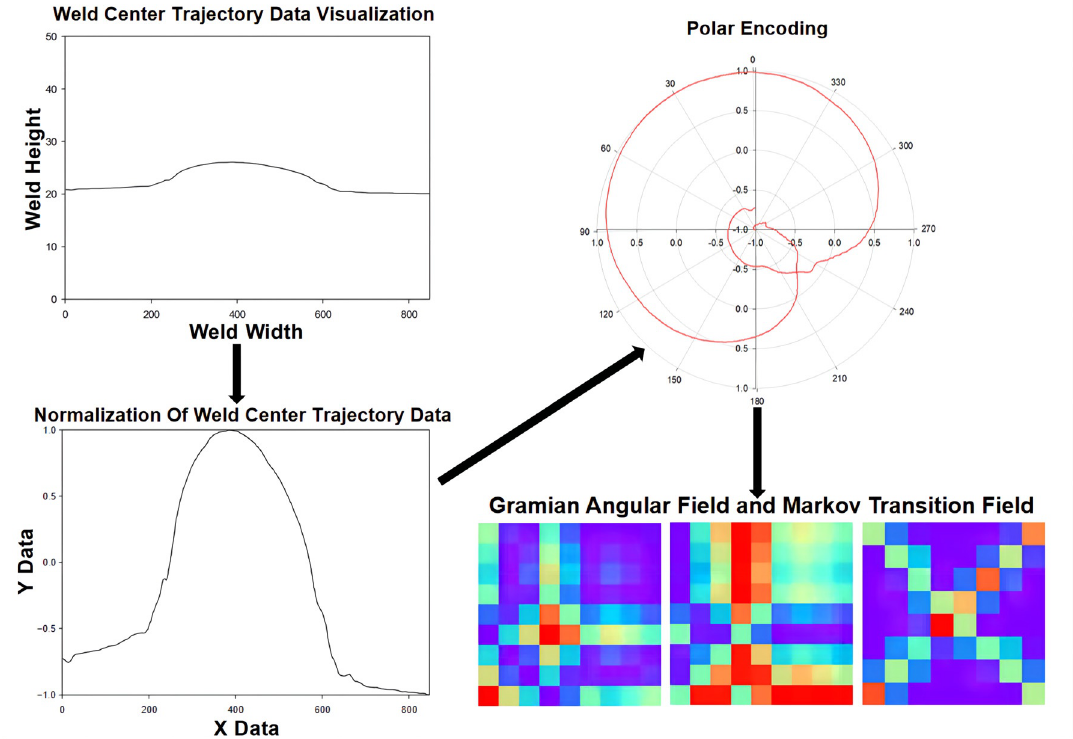
Figure 5. Coding process for welding center track data using GAF and MTF methods .